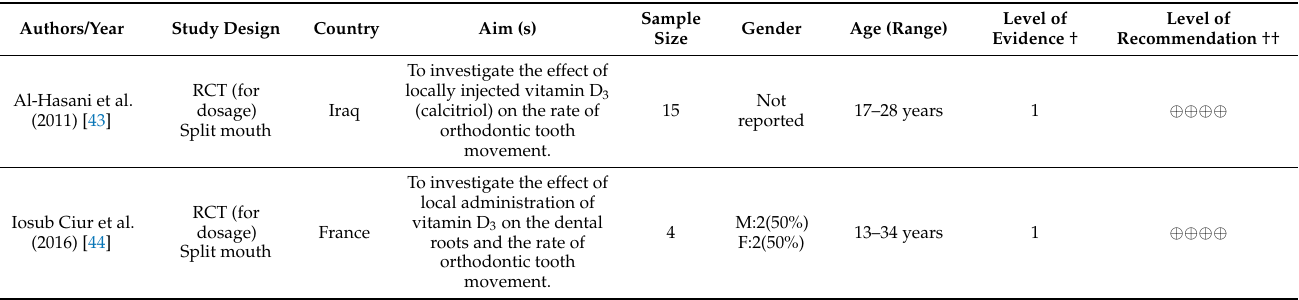
Table 5. The characteristics of clinical trials included in the systematic